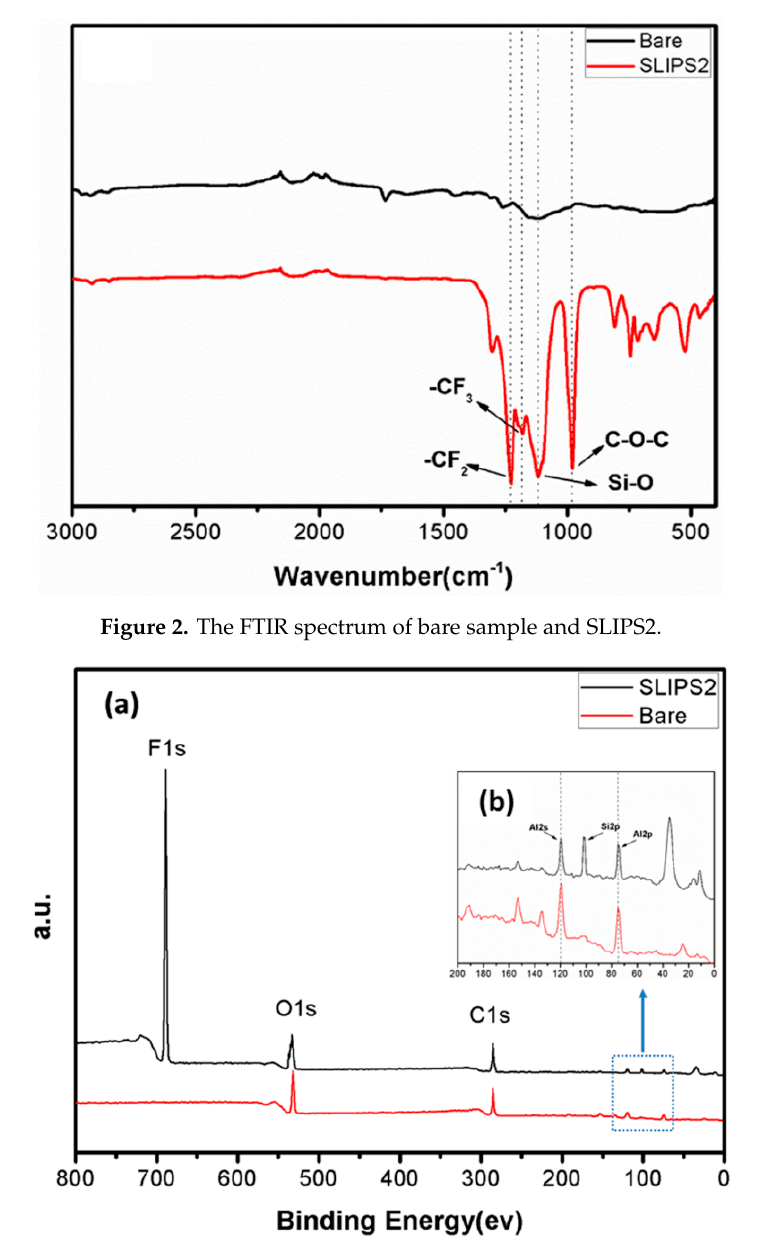
Figure 3. The XPS spectrum of bare sample and SLIPS2: ( a ) 0–800 eV; ( b ) 0–200 eV.